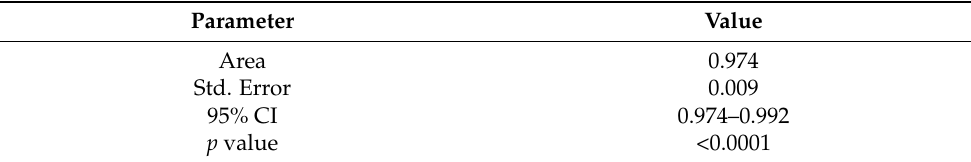
Figure 3. True positive (TP), true negative (TN), false positive (FP), and false negative (FN) propor ‐ tions. Table 4. Performance characteristics at 0.208. Parameters